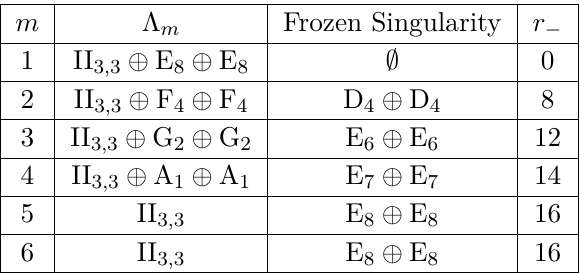
Table 1 . Momentum lattices Λ m for the moduli spaces of heterotic Z m -triples. The gauge group rank for m = 1 is 19, which is just the Narain component. The case m = 2 is dual to but not the same as the CHL component [10]. The frozen singularities correspond to the orthogonal complements of Λ m , → II 19 , 3